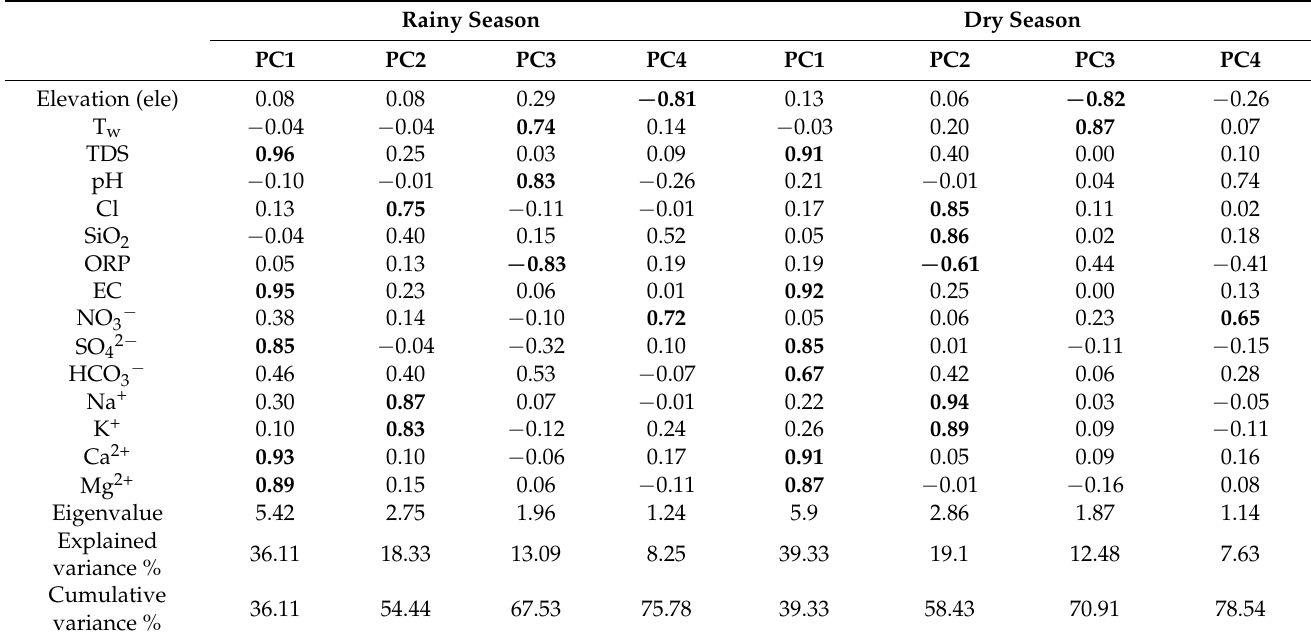
Table 4. Results of the principal component analysis on the first four rotated PCs during the rainy season and the dry